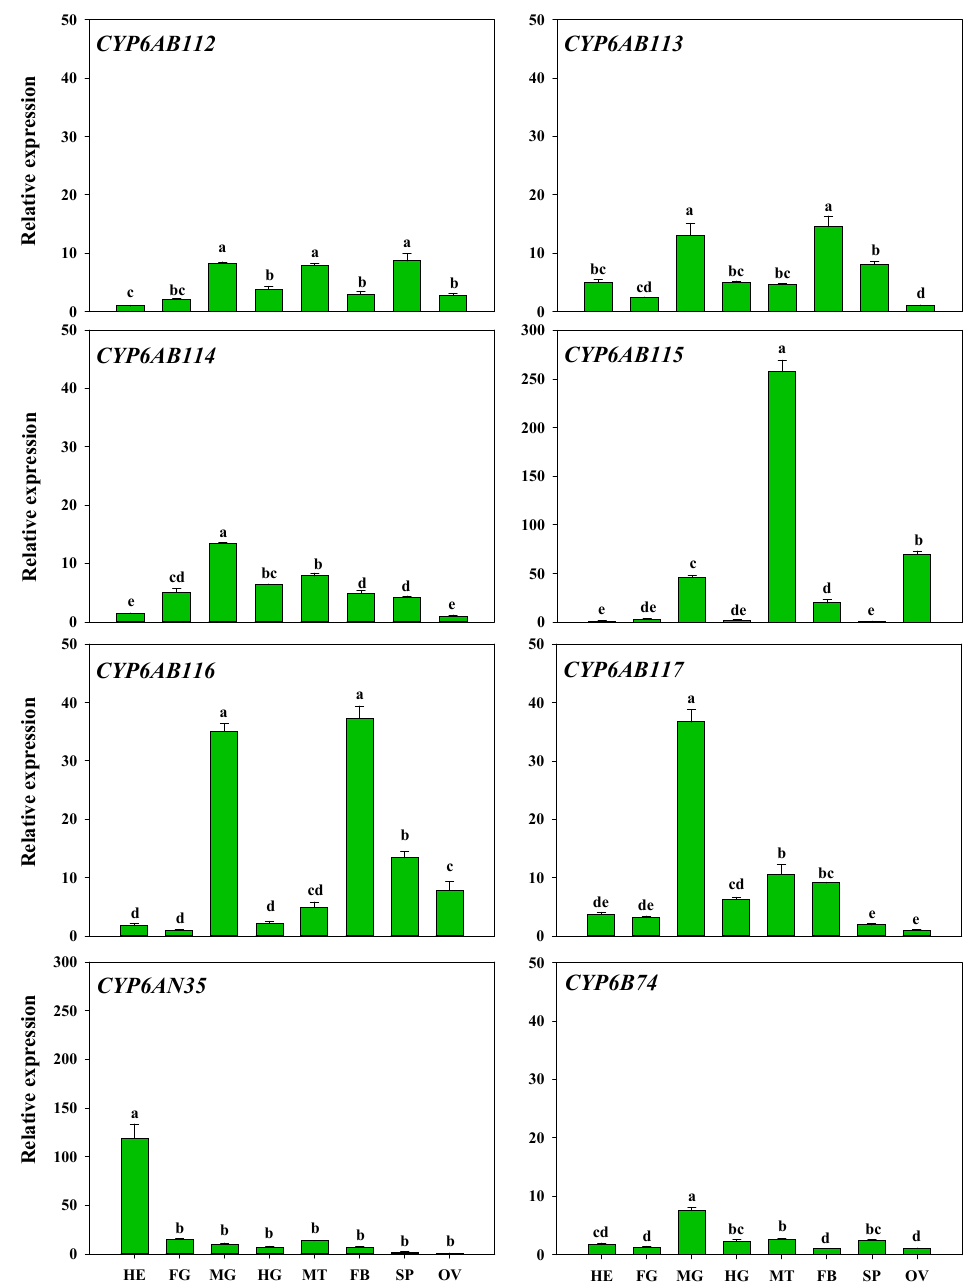
Figure 4. Expression patterns of eight CYP6 genes in different tissues of G. molesta. Note: head (HE), foregut (FG), midgut (MG), hindgut (HG), Malpighian tubule (MT), fat body (FB), spermary (SP), and ovary (OV). Each treatment included three biological replicates. The data in the bar charts are presented as the means ± SEs. Different letters indicate significant differences at the p < 0.05 level, as determined by ANOVA and Tukey’s HSD test.